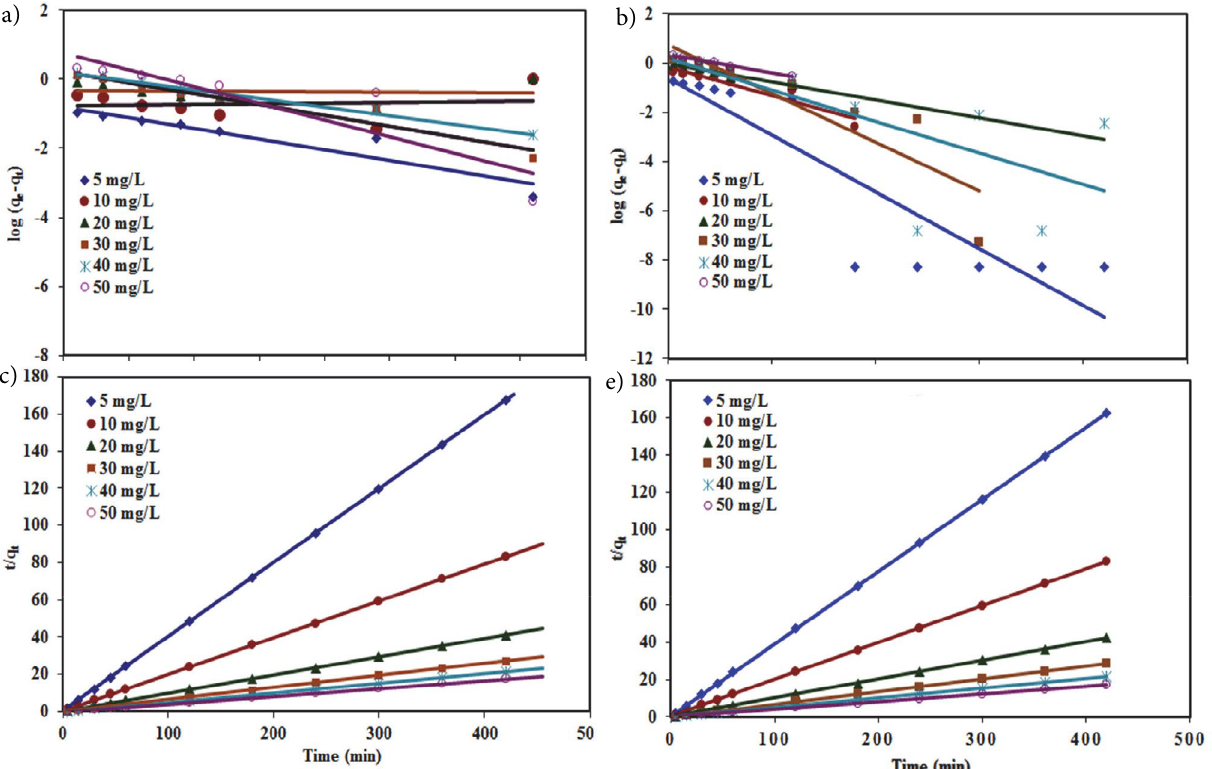
Figure 6. Pseudo-first-order kinetic model for MB (a) and MO (b), and pseudo-second-order kinetics model for MB (c) and MO (d) (experimental conditions: MB/MO concentrations = 5, 10, 20, 30, 40, and 50 mg/L, adsorbent dose = 2 g/L, pH 8 for MB and pH 6 for MO, temperature = 25